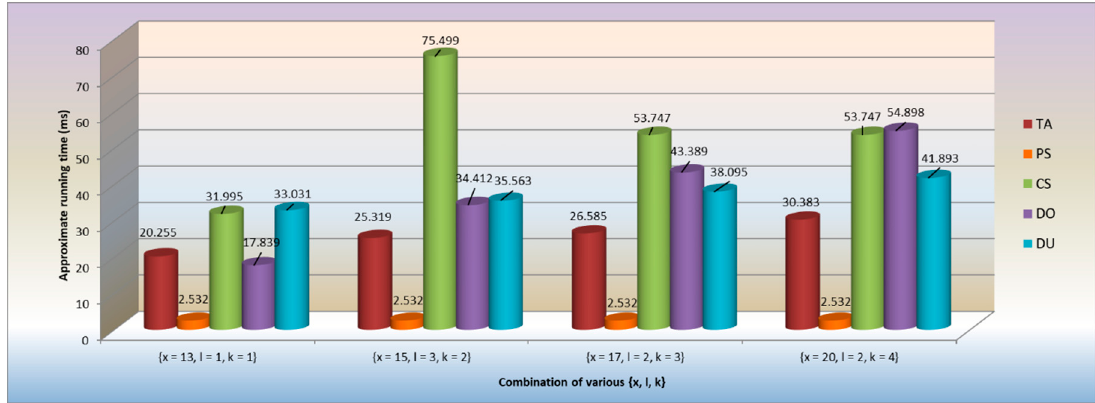
≈ 1.266 ms Figure 2 simulates the approximate running time of each participated party with re- spect to various { x , l , k } combinations. From this figure, we can observe that the running time of the PS remains constant no matter how the combination changes. As for the DU, its running time is mainly affected by the size of attribute sets. The major factor to affect